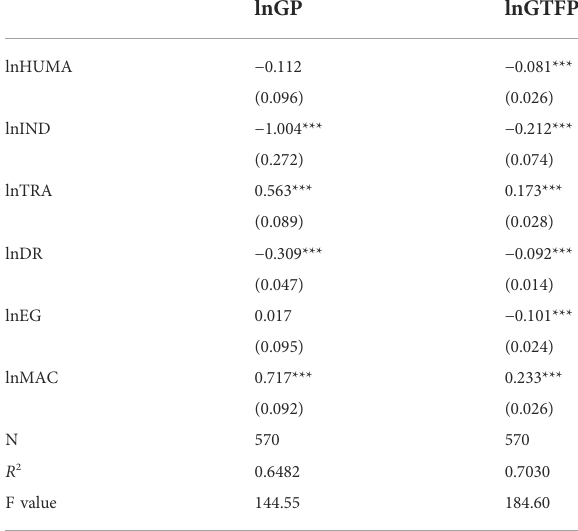
TABLE 3 Estimated results of the linear part of partially linear function-coef fi cient panel models. lnGP lnGTFP